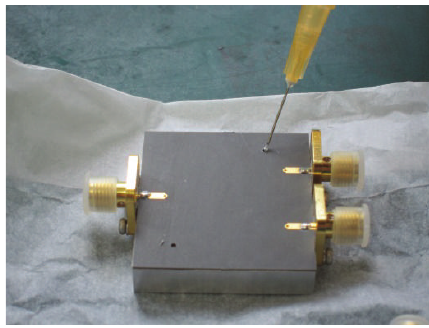
Figure 6: The LC filling method.